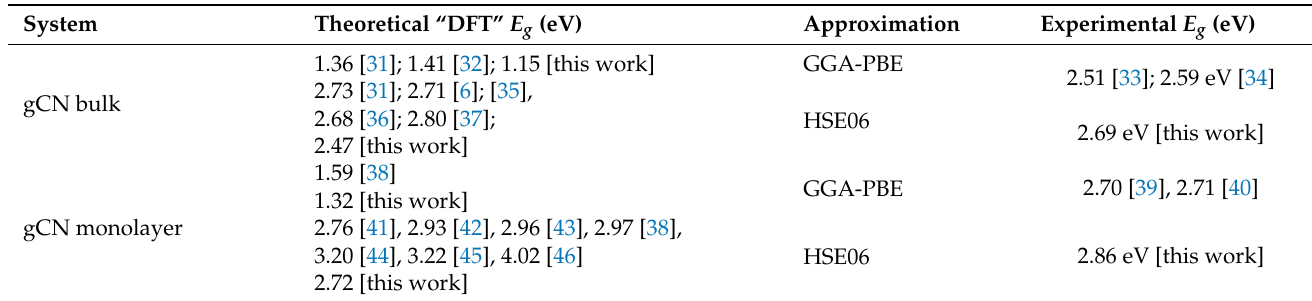
Table 1. gCN band gap energy comparison—experimental and